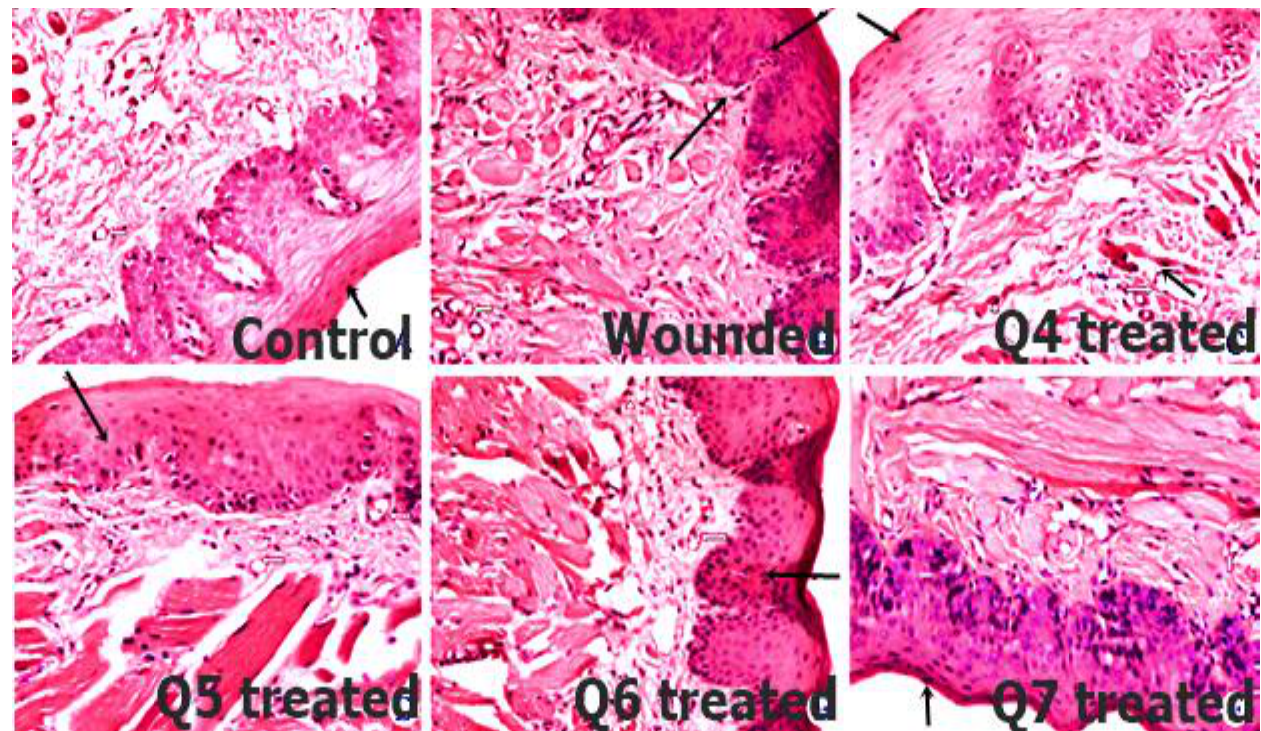
Figure 10. Histopathological evaluation of wounded buccal mucosal tissues by comparing control, wounded and treatment groups (Q4 – Q7). Newly generated mucosal tissues with complete epithelialization were evident with Q7 treatment group at day 5.